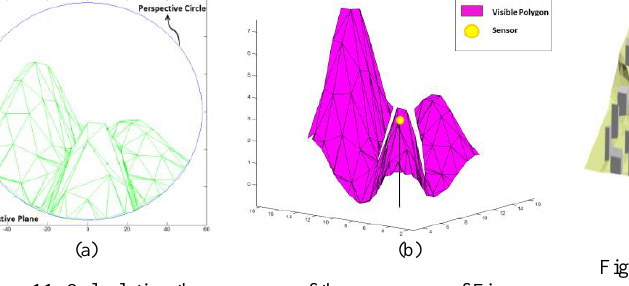
Figure 11. Calculating the coverage of the geosensor of Figure 10 (a) The perspective view; (b) The area covered by the geosensor